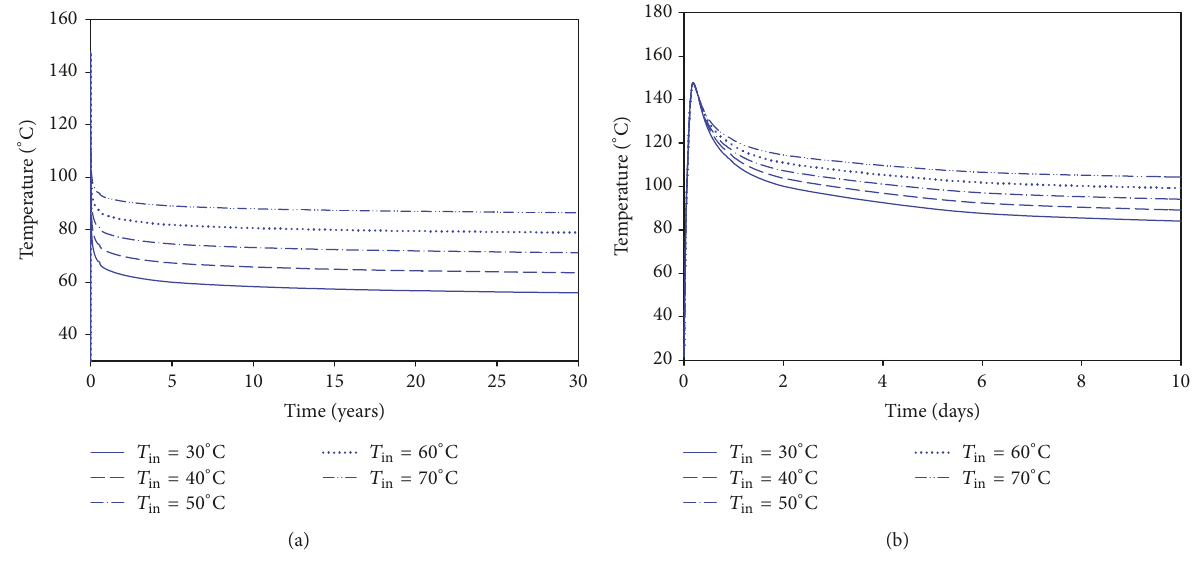
Figure 7: Variation with time of output temperature of the production well under different injection temperatures: (a) for large time period and (b) for short time